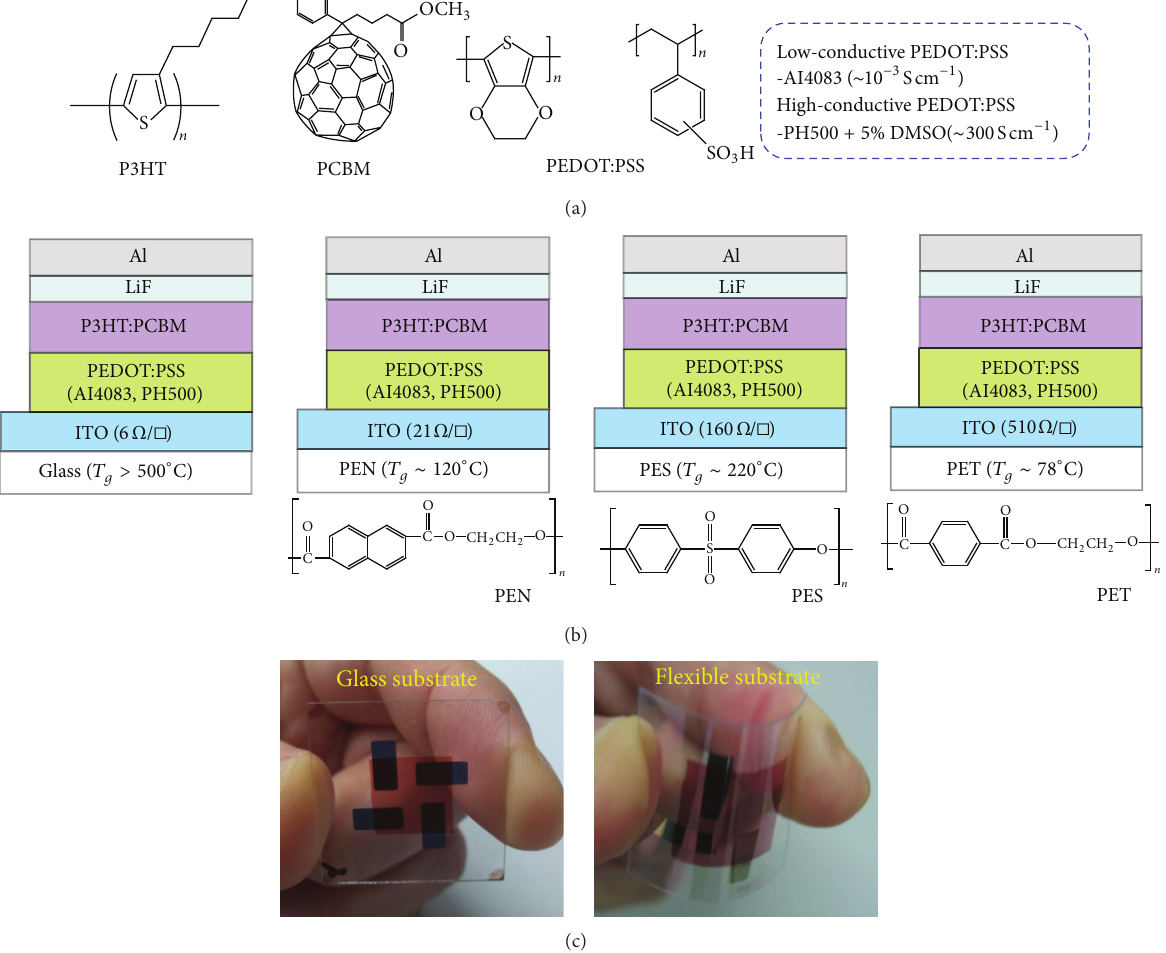
Figure 1: (a) Chemical structure of materials used in this work, (b) device structures with four different ITO substrates (glass and flexible plastics) and two different buffer layers (AI4083 and PH500) (note the chemical structures of plastic substrates), and (c) photographs of OPV devices fabricated using glass (left) and flexible plastic (right)